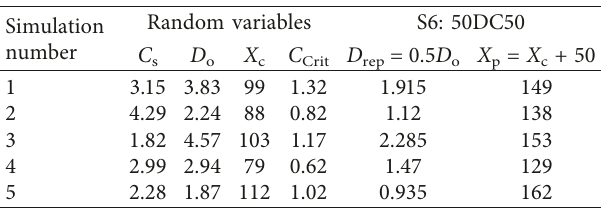
Table 4: Five generated random numbers for concrete structures with